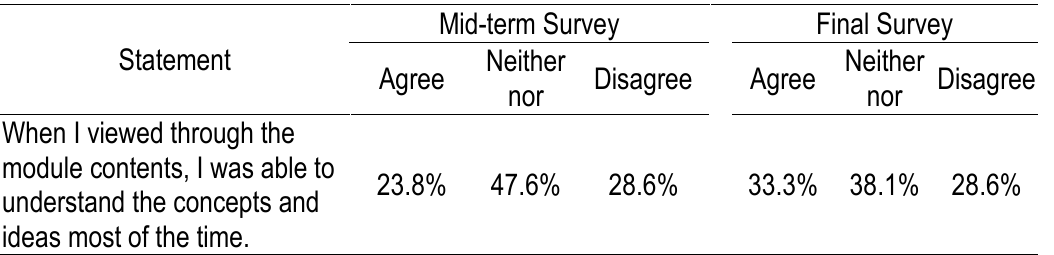
Table 8. Experience of online learning